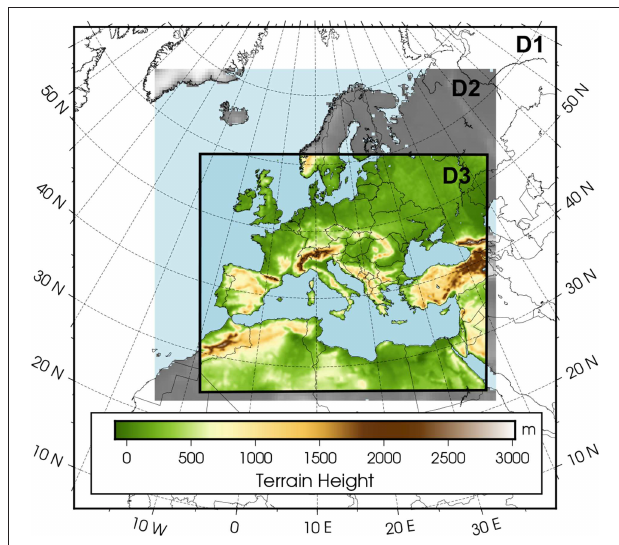
FIGURE 1 | Orography and boundaries of the simulated domains at 1.32 ◦ , 0.44 ◦ , and 0.11 ◦ horizontal spatial